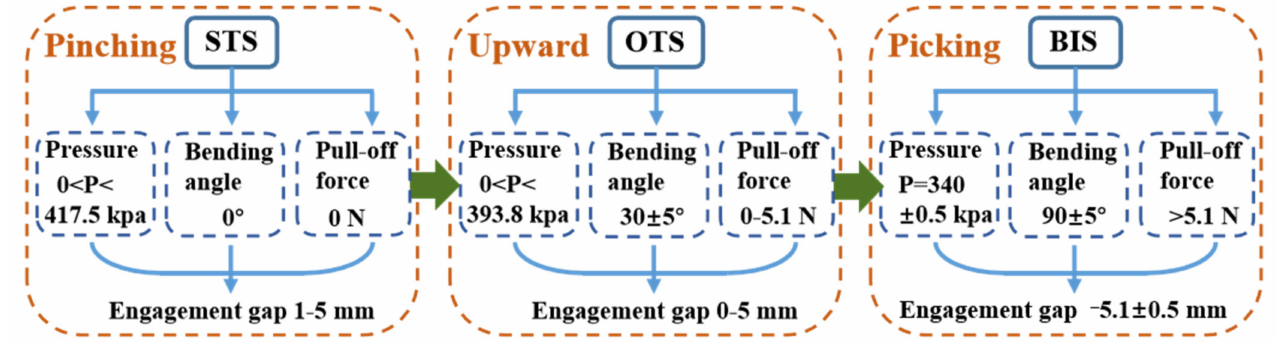
Figure 13. Force path of artificial shoot picking. BIS: stalks between buds and leaves; OTS: one and two leaves interstitial stalks; STS: stalks between the second and third